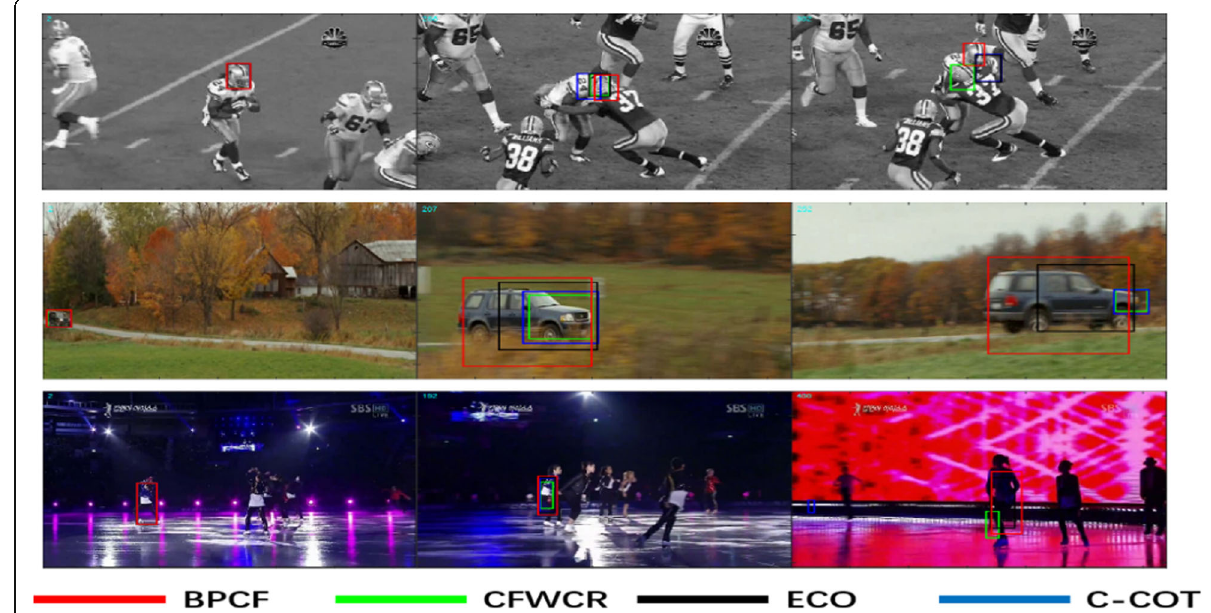
Fig. 1 Results on OTB2015. The comparison of BPCF and some state-of-the-art trackers on sample